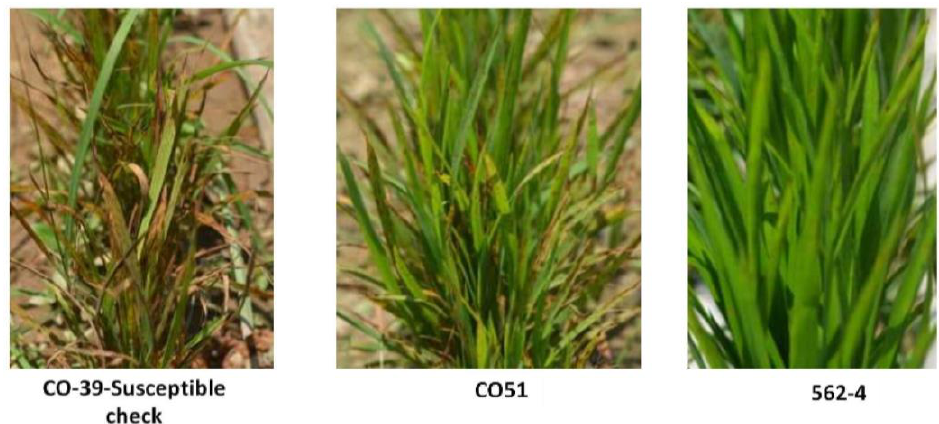
Figure 4. Response of the rice genotypes such as CO 39 (susceptible check), CO 51 (recurrent parent) and 562-4 (donor parent) to the blast